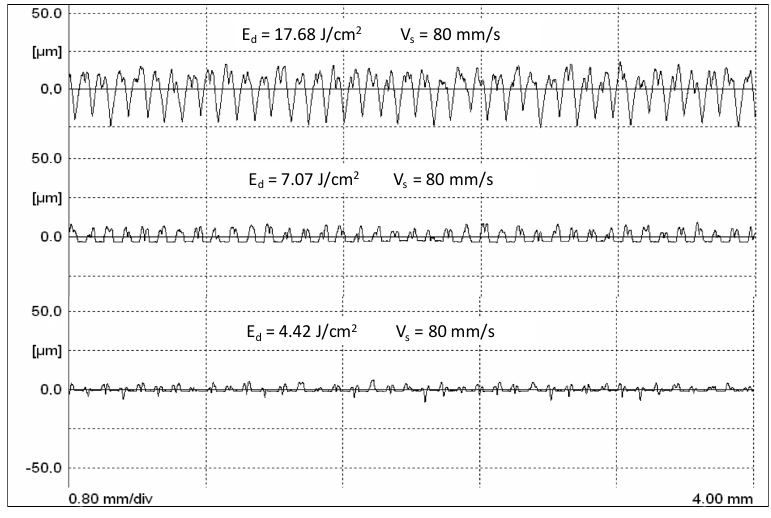
Figure 3. Roughness profiles as a function of energy density of pulse and scan speed of the beam.